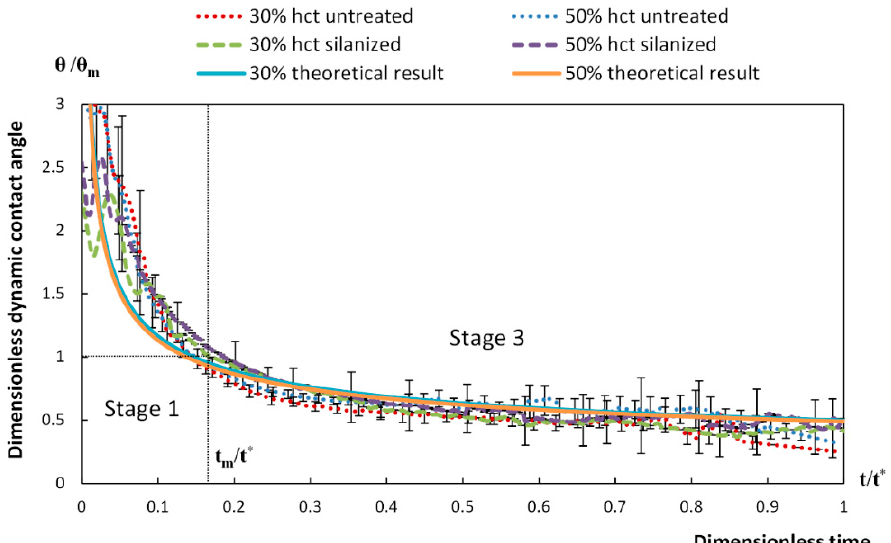
Figure 6. Dimensionless dynamic contact angle of blood droplet in the case of spreading over silanized and untreated Whatman 903 paper [35].